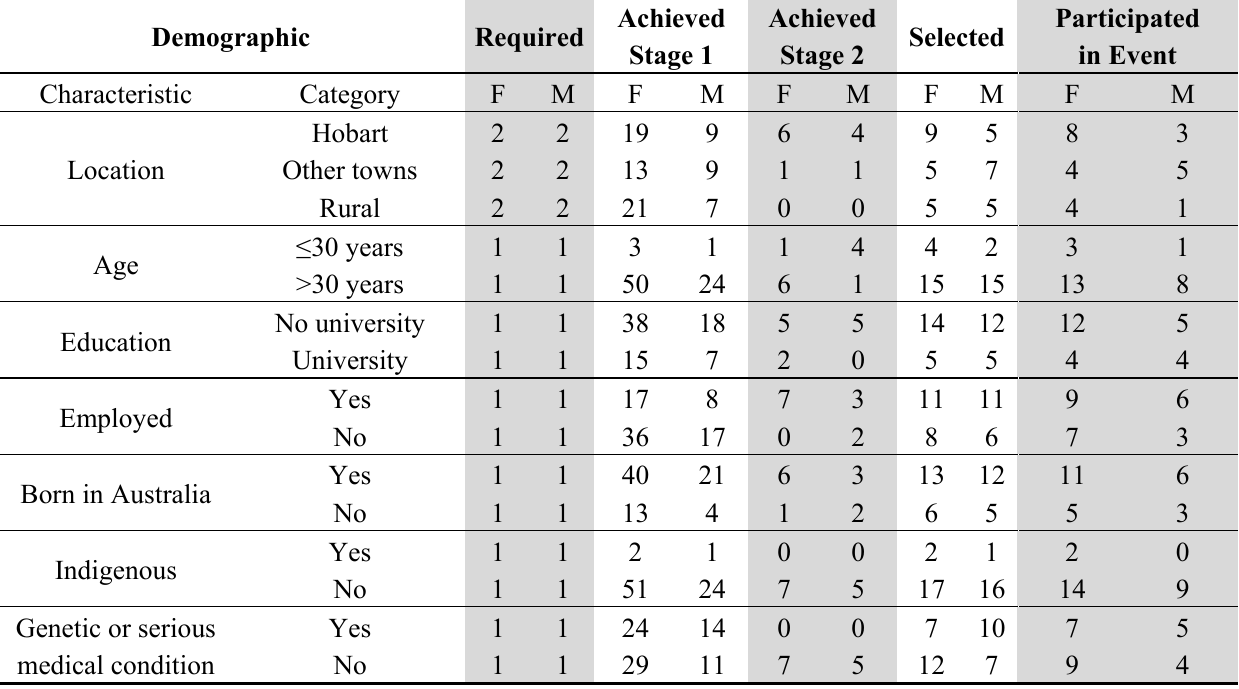
Table 1. Required and achieved numbers of participants across demographic categories for all stages of recruitment and